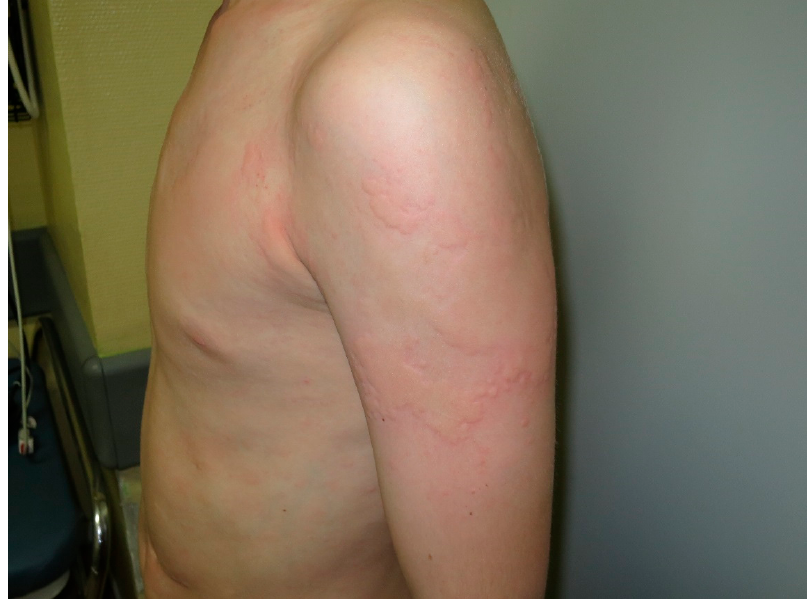
Figure 1. Urticaria. Pale to red, well-demarcated, transient swellings, involving the dermis, mainly at the thorax and the left